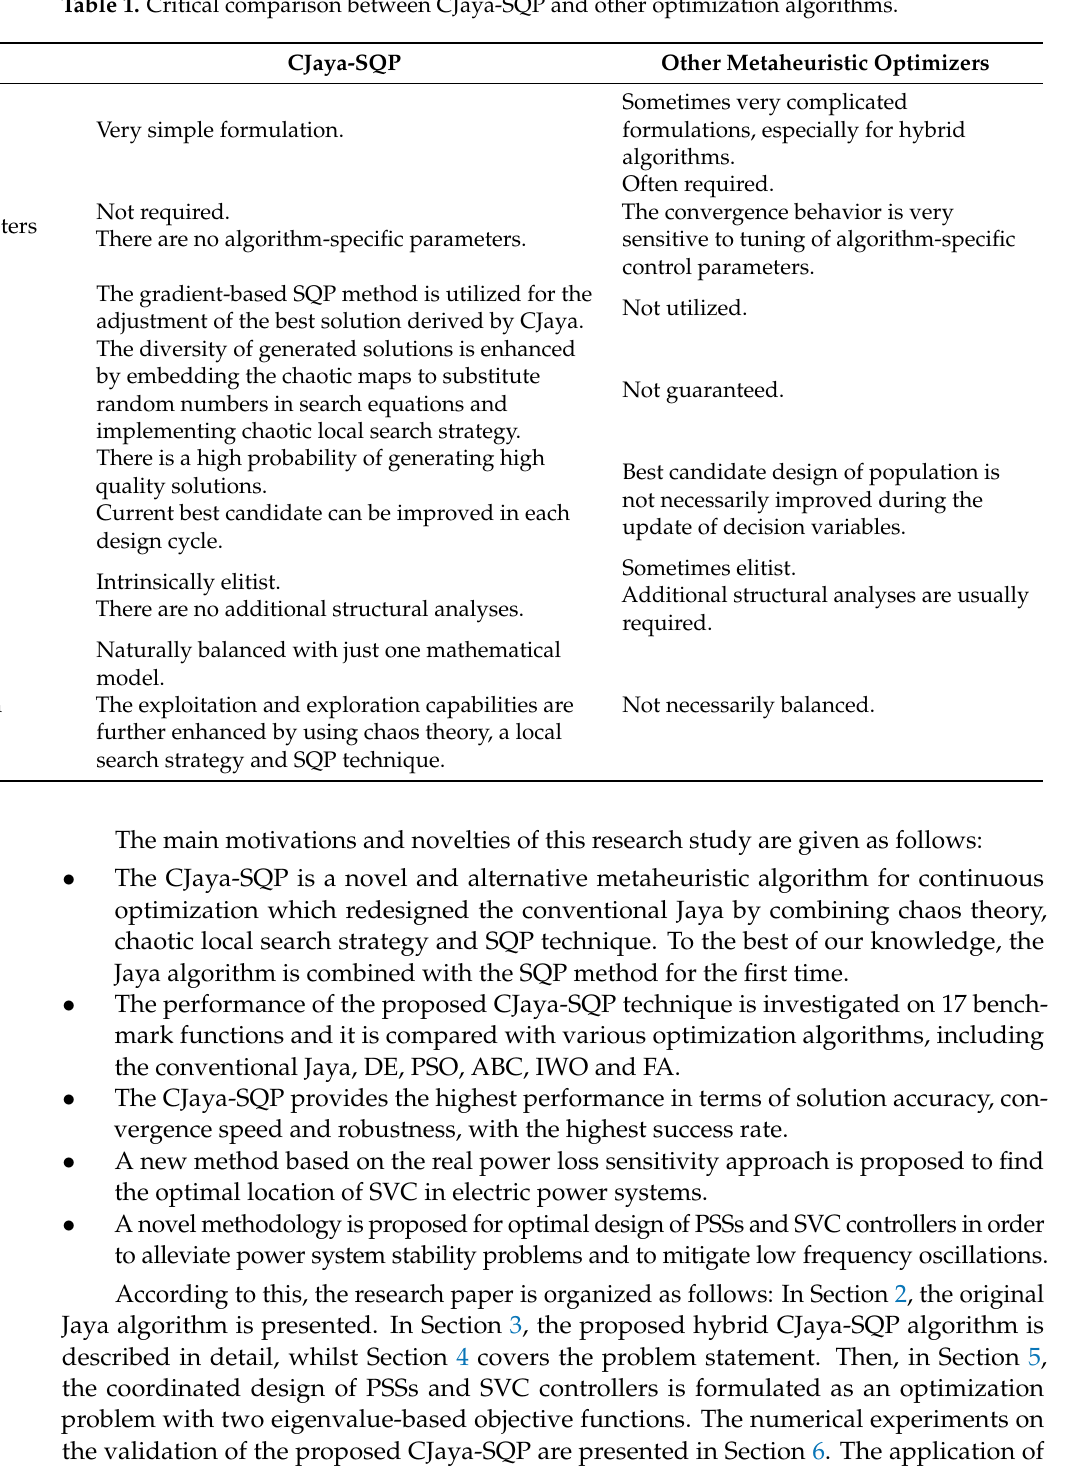
Table 1. Critical comparison between CJaya-SQP and other optimization